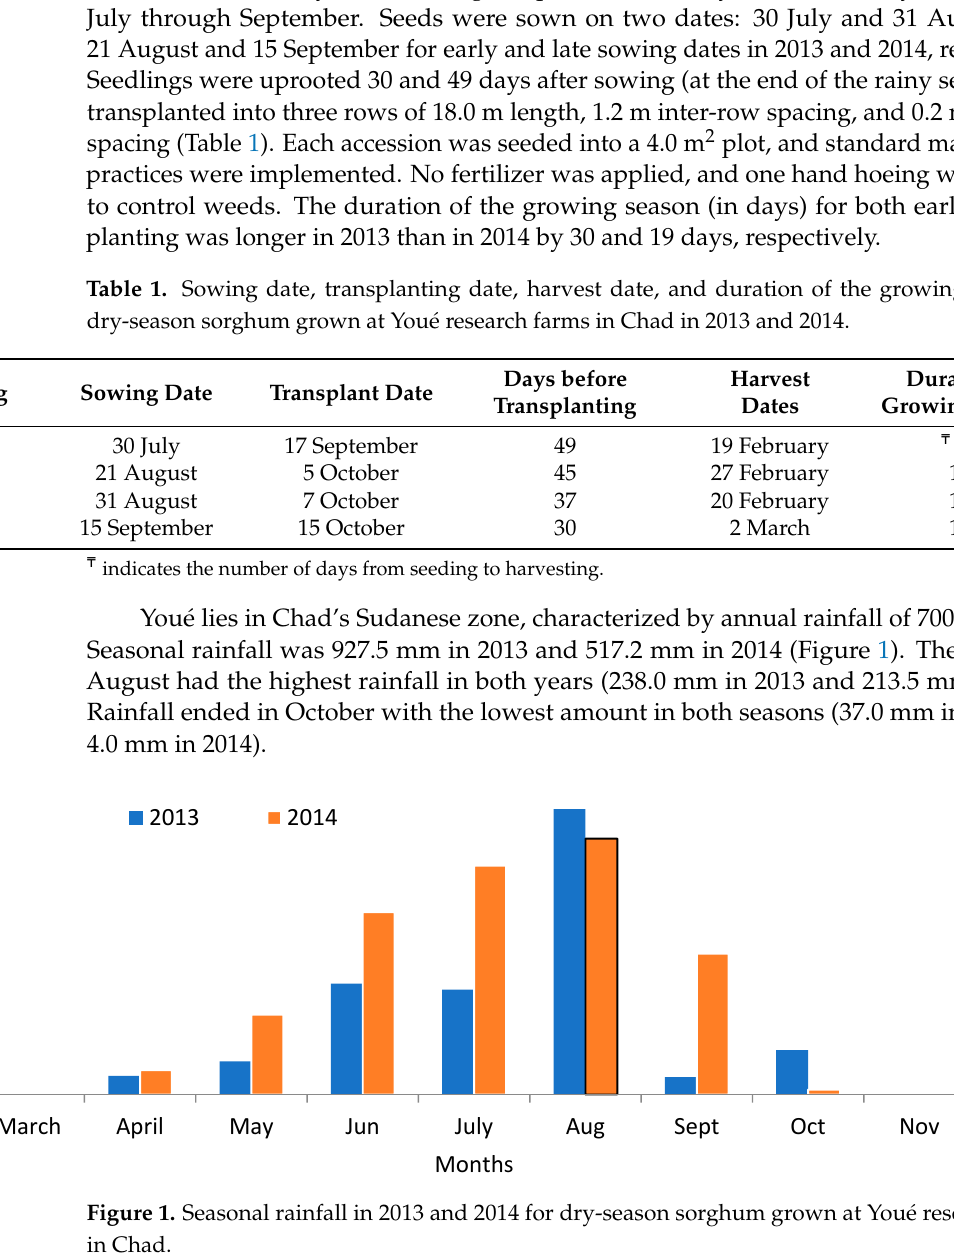
Table 1. Sowing date, transplanting date, harvest date, and duration of the growing season of dry- season sorghum grown at Youé research farms in Chad in 2013 and 2014. Transplant Days before Harvest Year Sowing Sowing Date Date Transplanting Dates